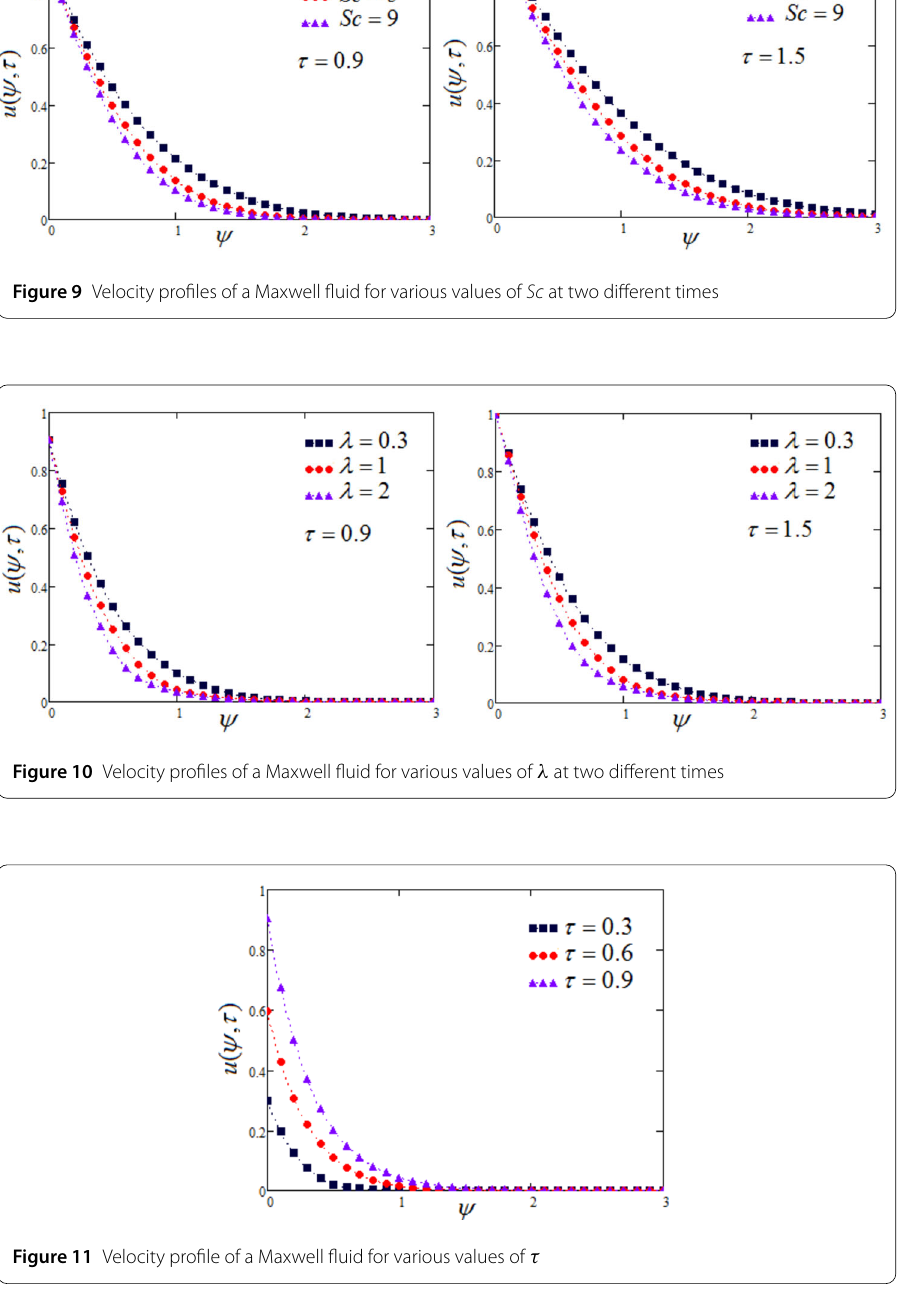
to the increase in the value of the Schmidt number. The involvement of the concentration factor of fluid velocity on the fluid flow is very important and it cannot be overlooked. Figure 5 describes the effects of Gm . The mass Grashof number is generally defined as the ratio of mass buoyancy force to viscous force, which causes unrestricted convection. It is noted that the velocity is enhanced in the case of increasing Gm